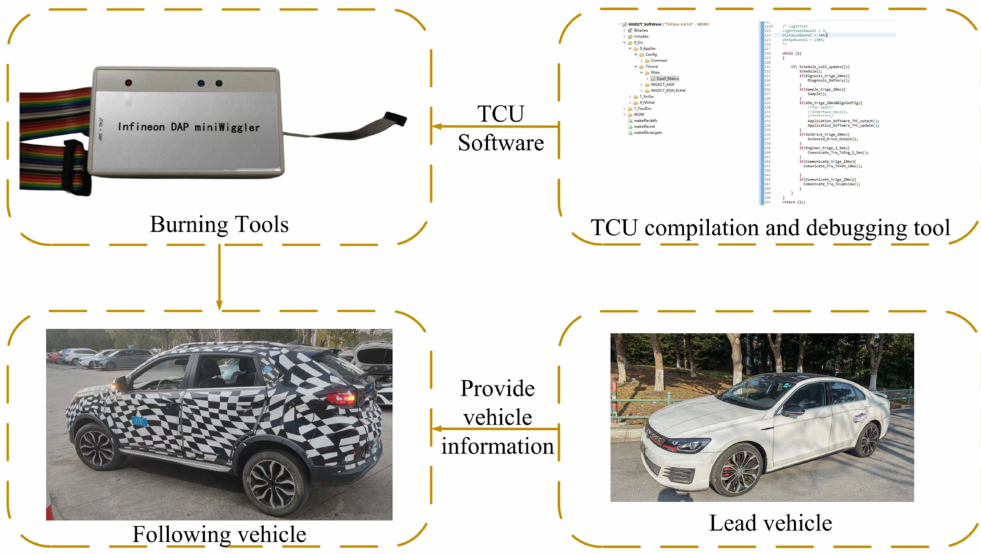
Figure 7. Schematic diagram of the real vehicle experiment.